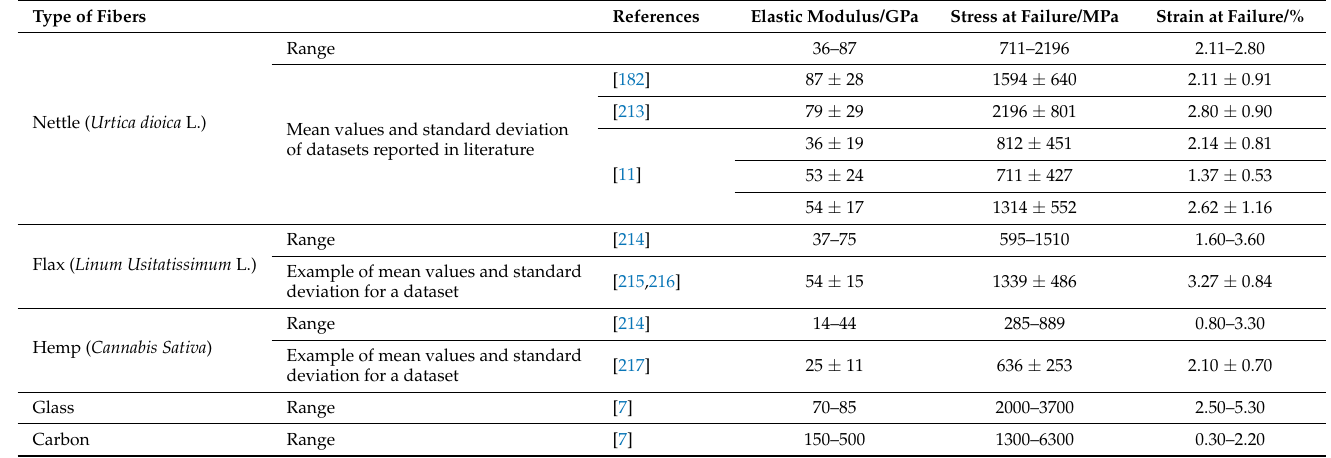
Table 4. Tensile properties of nettle ( Urtica dioica L.) fibers compared to other European lignocellulosic fibers and usual synthetic